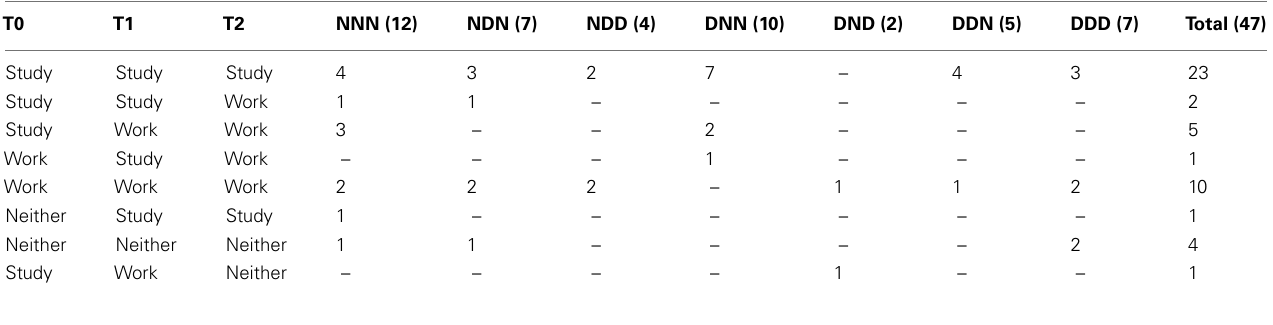
Table 3 | Occupational status and cannabis dependence trajectoriesT0–T1–T2 ( n = 47). T0